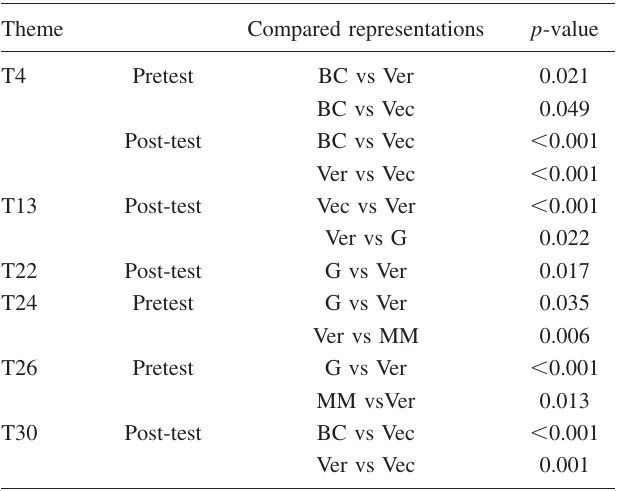
TABLE V. Statistically significant differences (cid:1) p (cid:2) 0.05 (cid:2) be- tween correct answers of items (cid:1) representations (cid:2) in themes (cid:1) McNe- mar’s test (cid:2) . Abbreviations: BC=bar chart, Ver=verbal, Vec =vectorial, G=graphical, and MM=motion map.